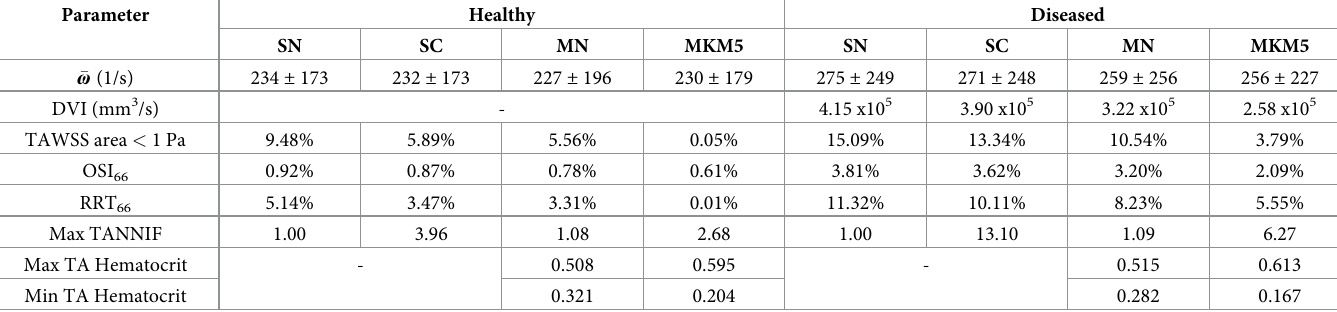
Table 3. Parameters averaged over the final cardiac cycle for the healthy and stenosed geometries (TA = time averaged).